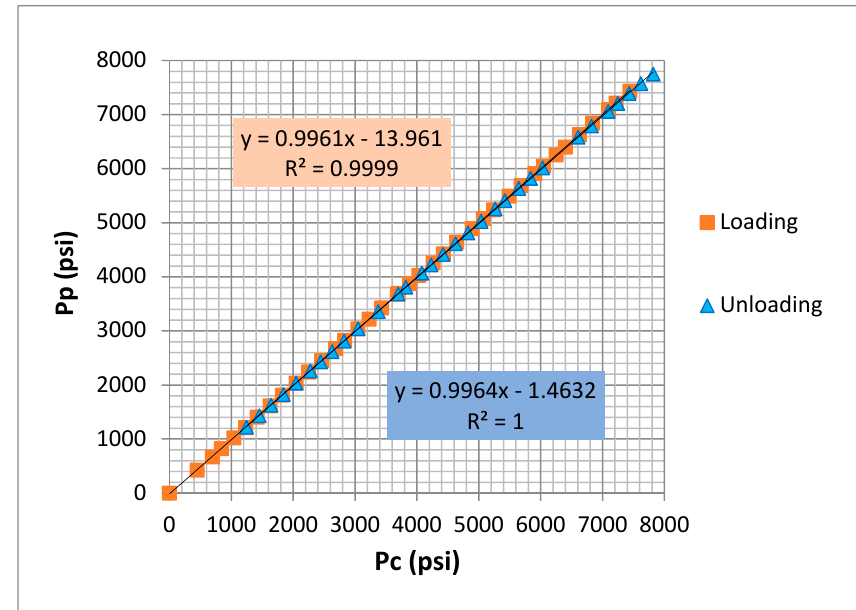
𝑃 (cid:3043) vs. (cid:3030) for C4.